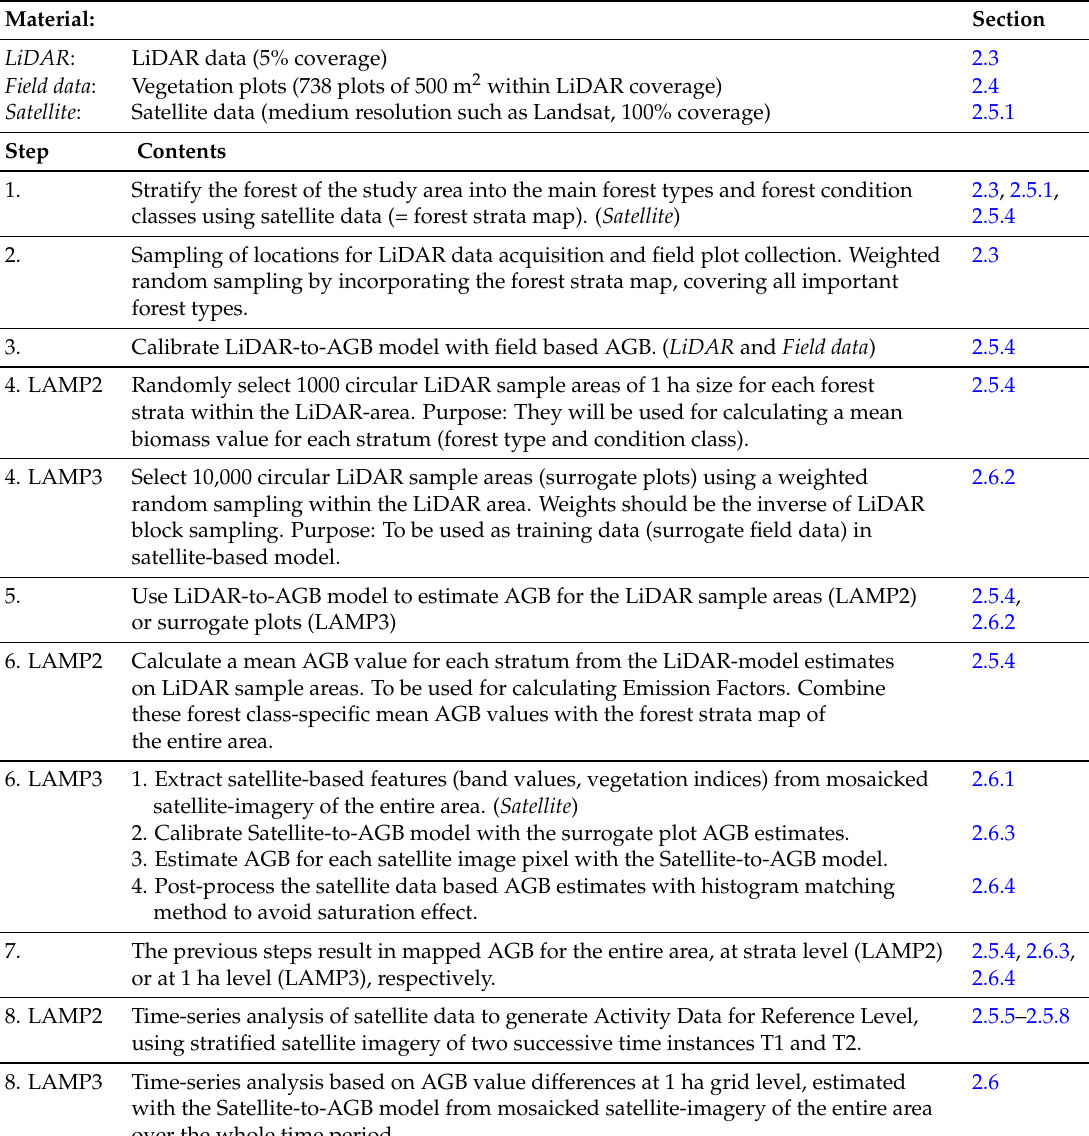
Table 1. Overview of LiDAR-Assisted Multi-source Program (LAMP)2 and LAMP3